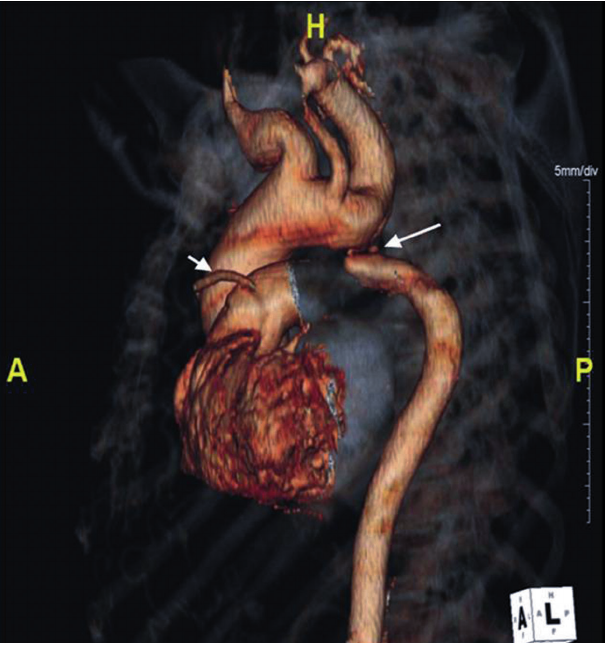
Fig. 2 – Postoperative angiotomography shows interruption of aortic arch after subclavian artery origin (arrow) and a patent saphenous graft (arrow)